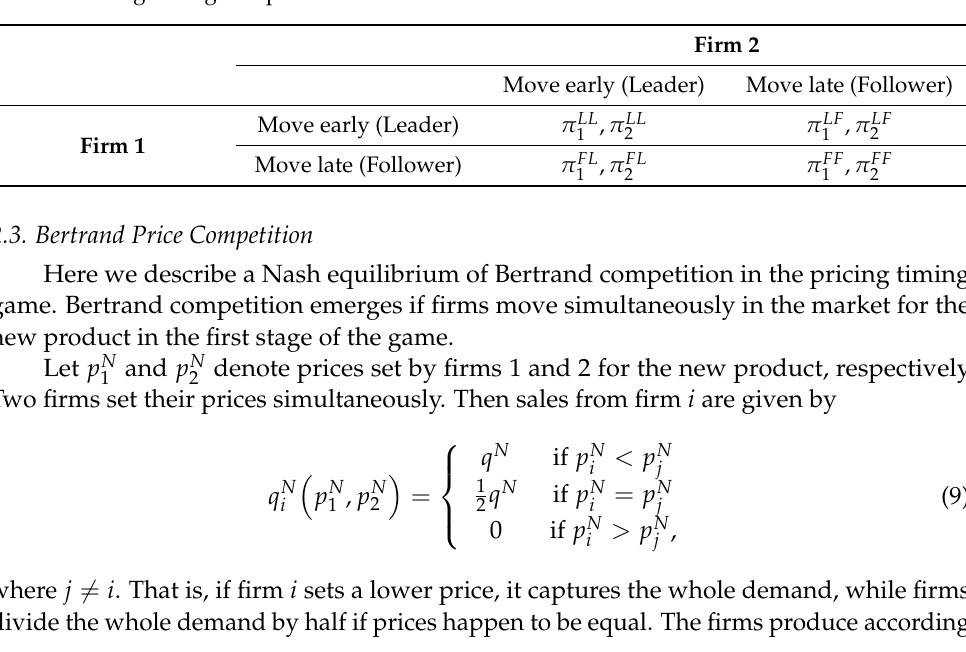
Table 1. Pricing timing and